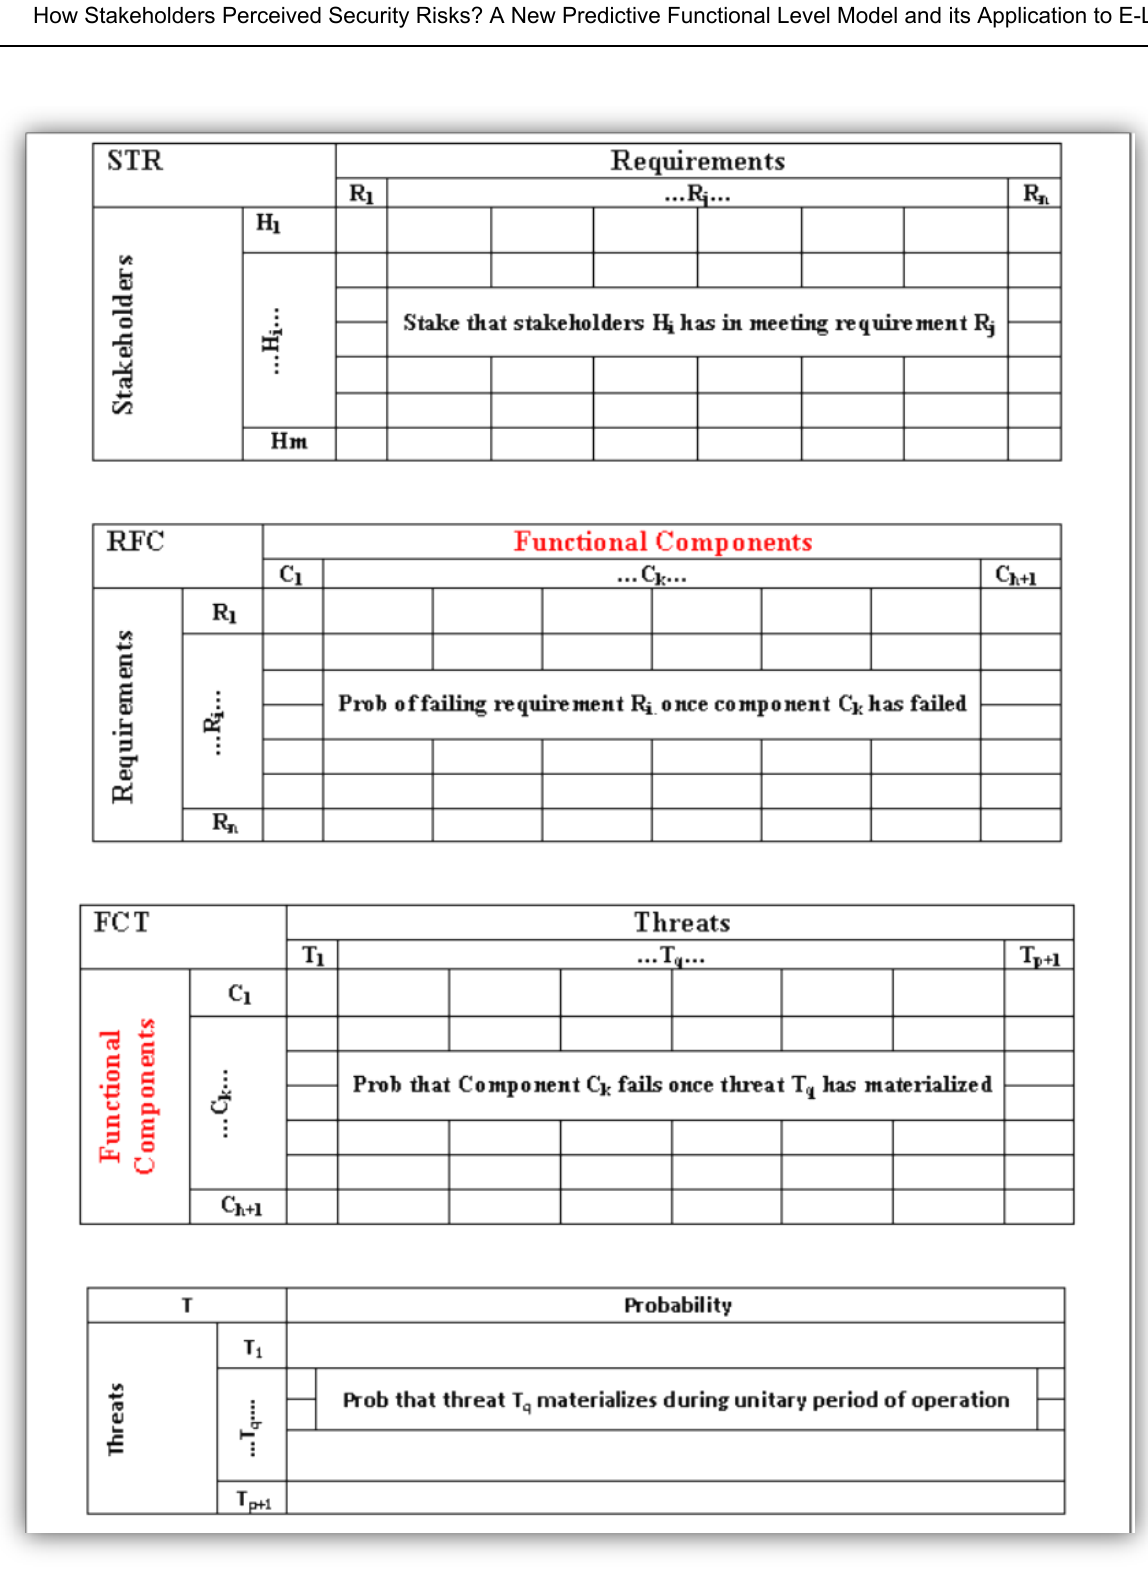
Figure 1. Illustration of the FSRM